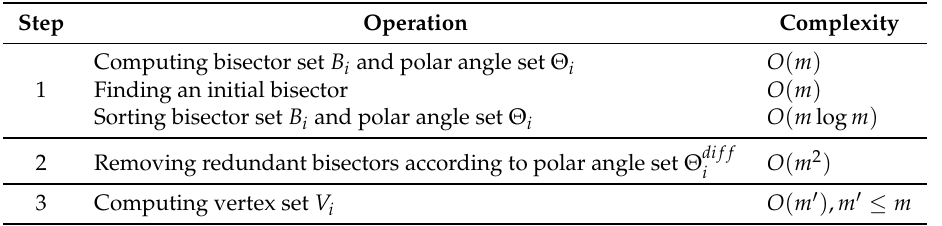
Table 2. The computational complexity of the Range-Constrained Voronoi Cell (RCVC)